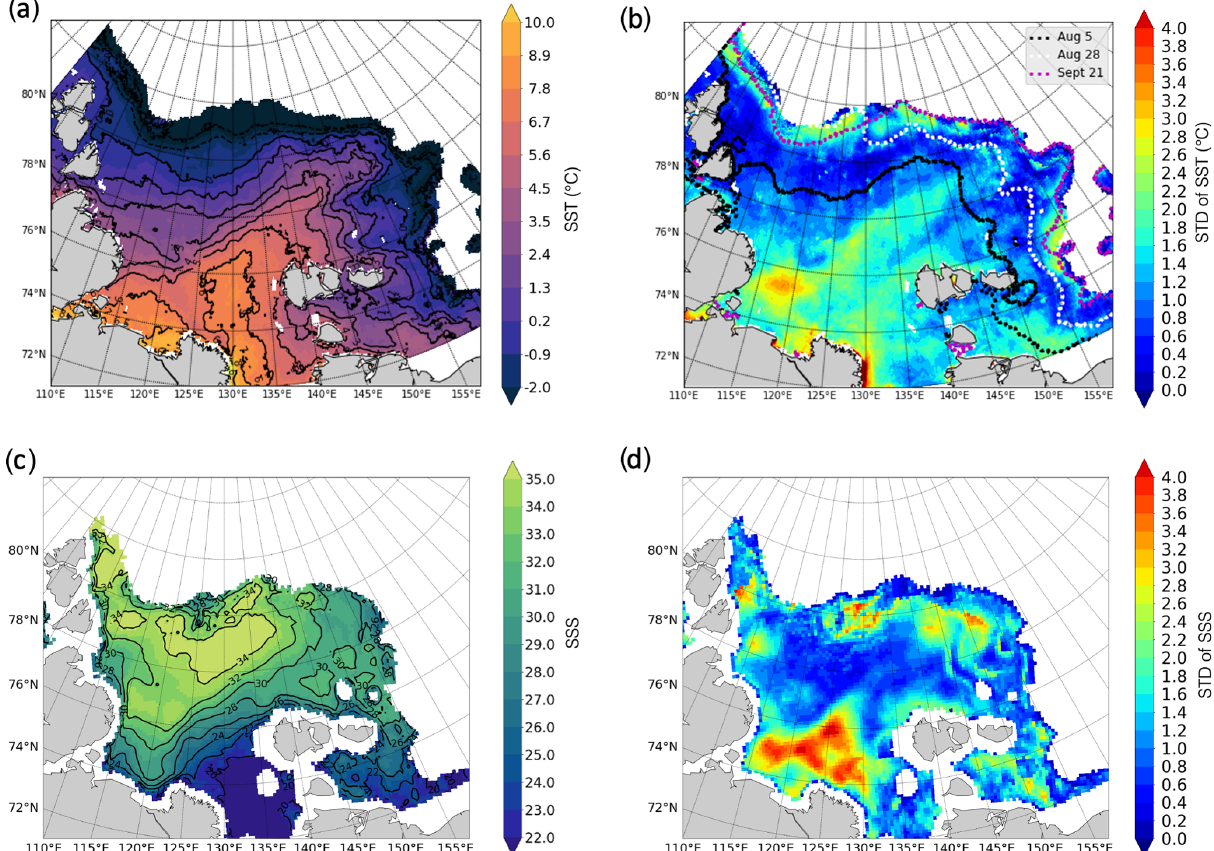
Figure 6. Mean DMI SST (a) with its SD (b) and mean SMOS SSS (c) with its SD (d) for August–September 2018. The dotted lines in (b) show the position of the sea ice edge at different moments of time before and during the ARKTIKA-2018